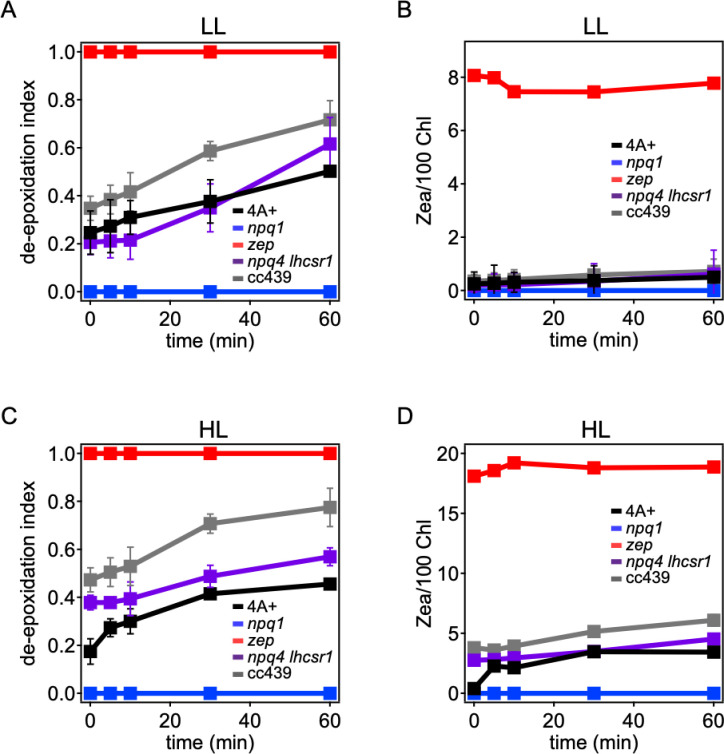
Violaxanthin de-epoxidation kinetics in Chlamydomonas reinhardtii WT and mutant strains.Violaxanthin de-epoxidation kinetics were measured upon 60 min of strong light treatment (red light 1500 μmol m−2s−1) of low-light (LL) or high-light (HL) acclimated cells. Panel A, C: de-epoxidation indexes at different time points. Panel B, D: zeaxanthin content per 100 chlorophylls. De-epoxidation index was calculated from the molar concentration of zeaxanthin, anteraxanthin, and violaxanthin as ([zeaxanthin]+ [anteraxanthin]/2)/([zeaxanthin]+ [anteraxanthin]+ [violaxanthin]). The results reported are representative of three independent biological replicates for each genotype in LL or HL. Error bars are reported as standard deviation (N = 3).